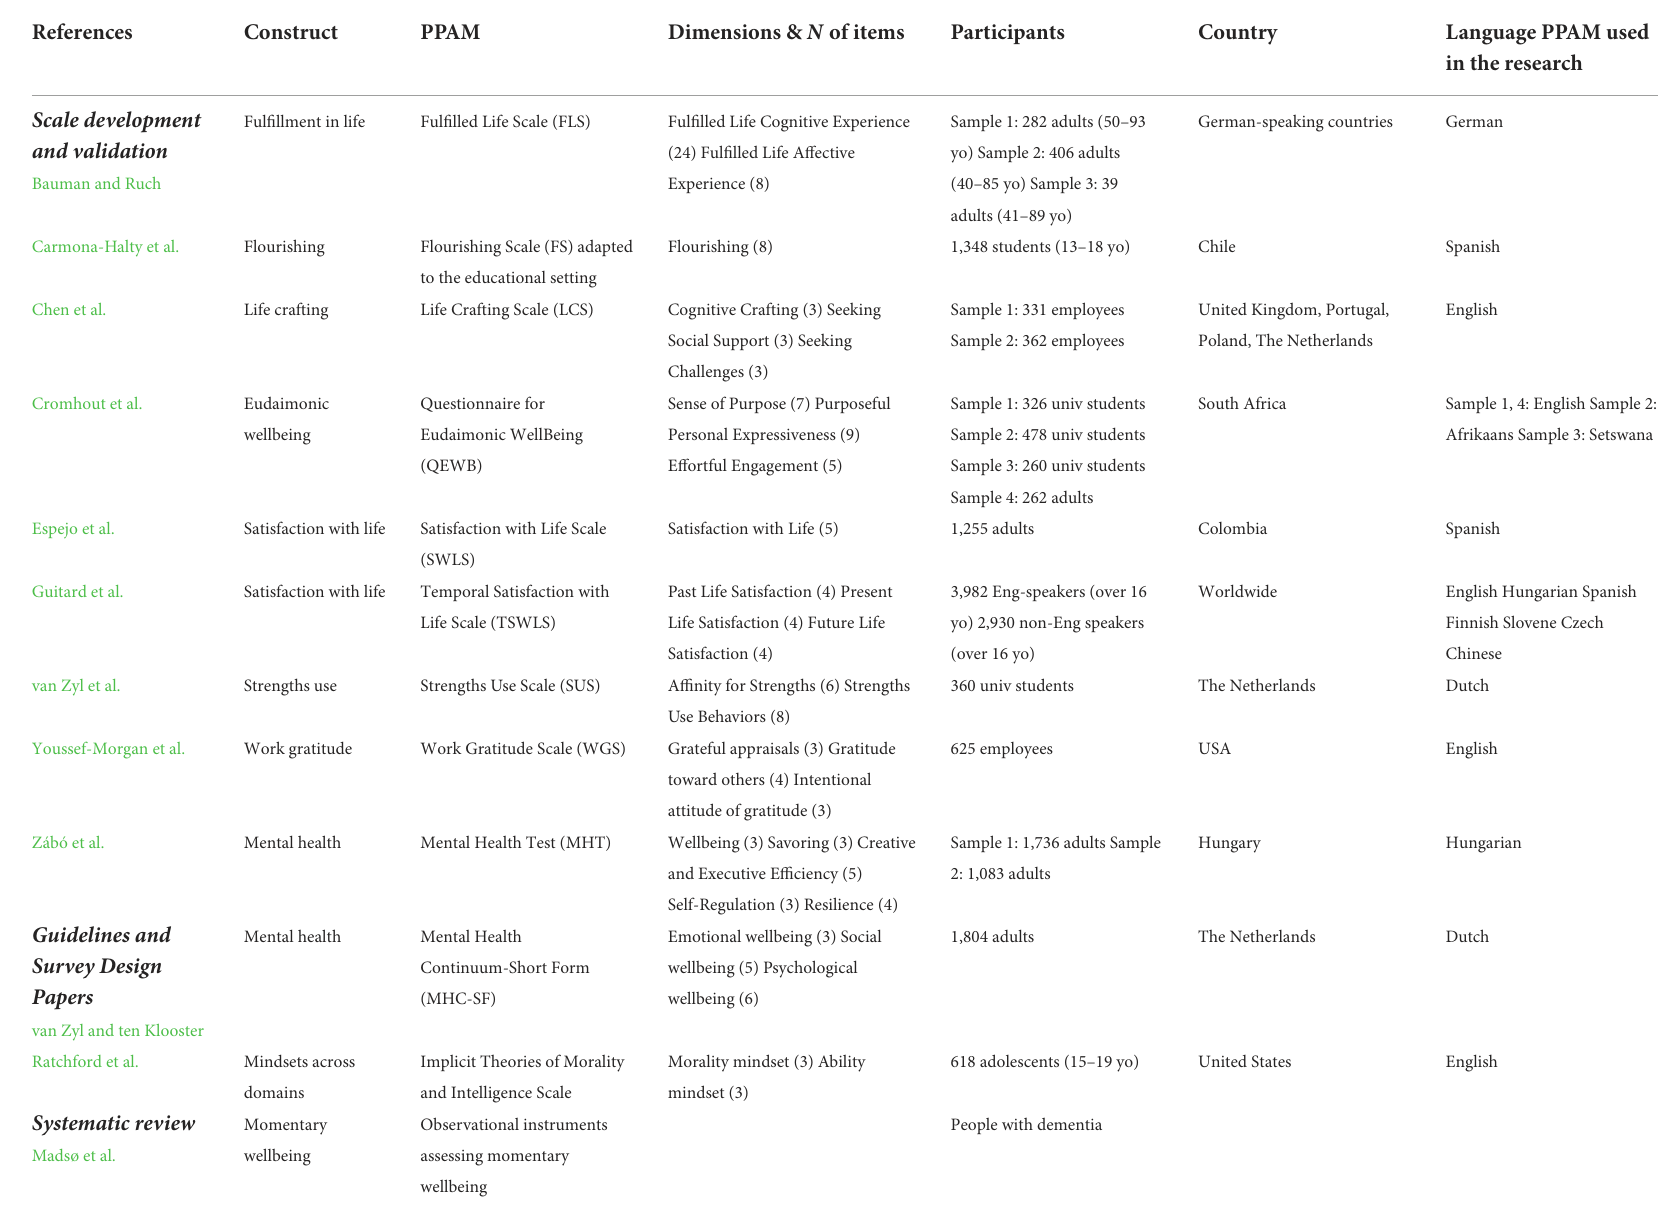
TABLE 1 Characteristics of the studies included in the Research